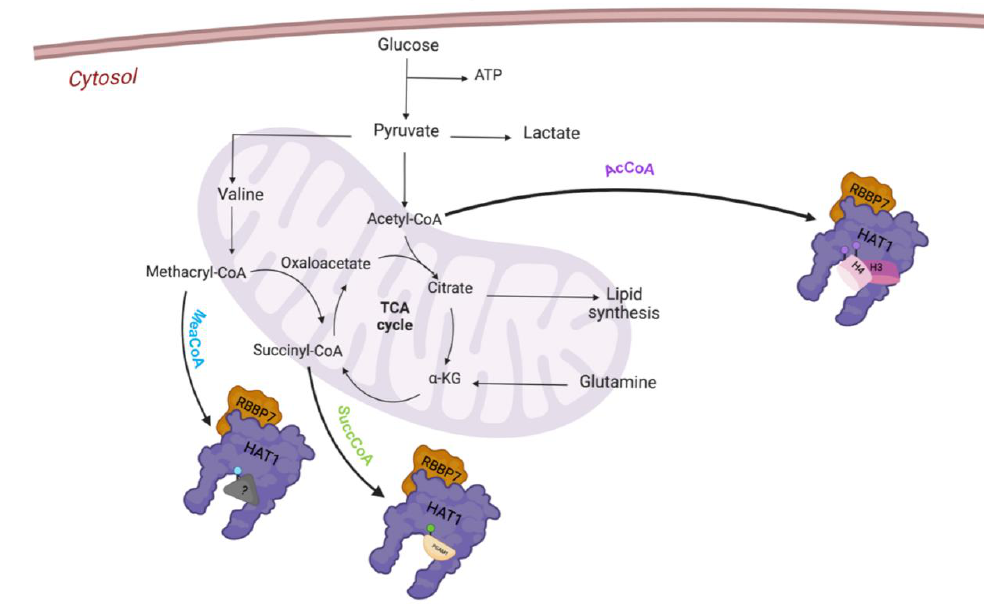
Figure 3. Representative enzymatic function of HAT1.